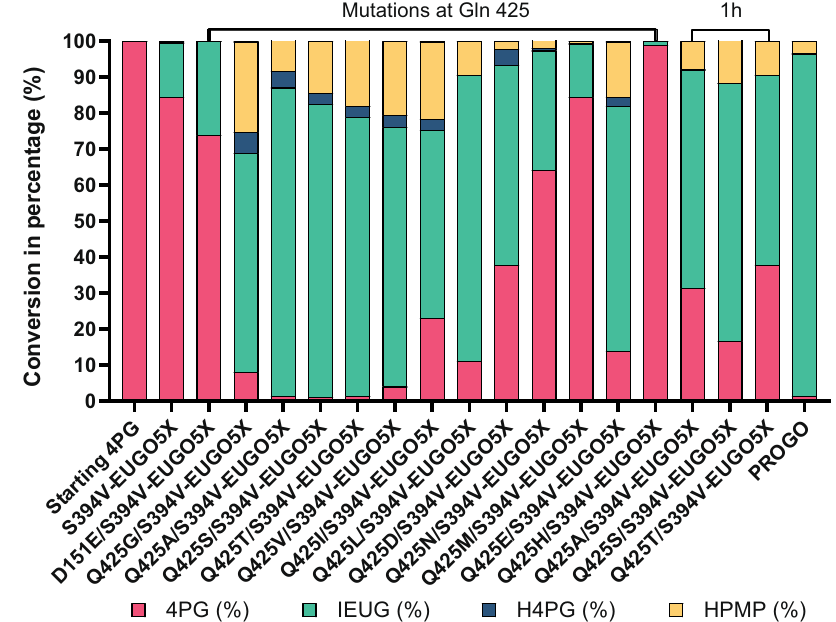
Fig. 6 | 4- n -Propylguaiacol conversion by puri fi ed EUGO5X mutants. 4- n -pro- pylguaiacol (4PG), isoeugenol (IEUG), 4-(1-hydroxypropyl) − 2-methoxyphenol (H4PG), 1-(4-hydroxy-3-methoxyphenyl) − 1-propanone (HPMP) are shown in red,